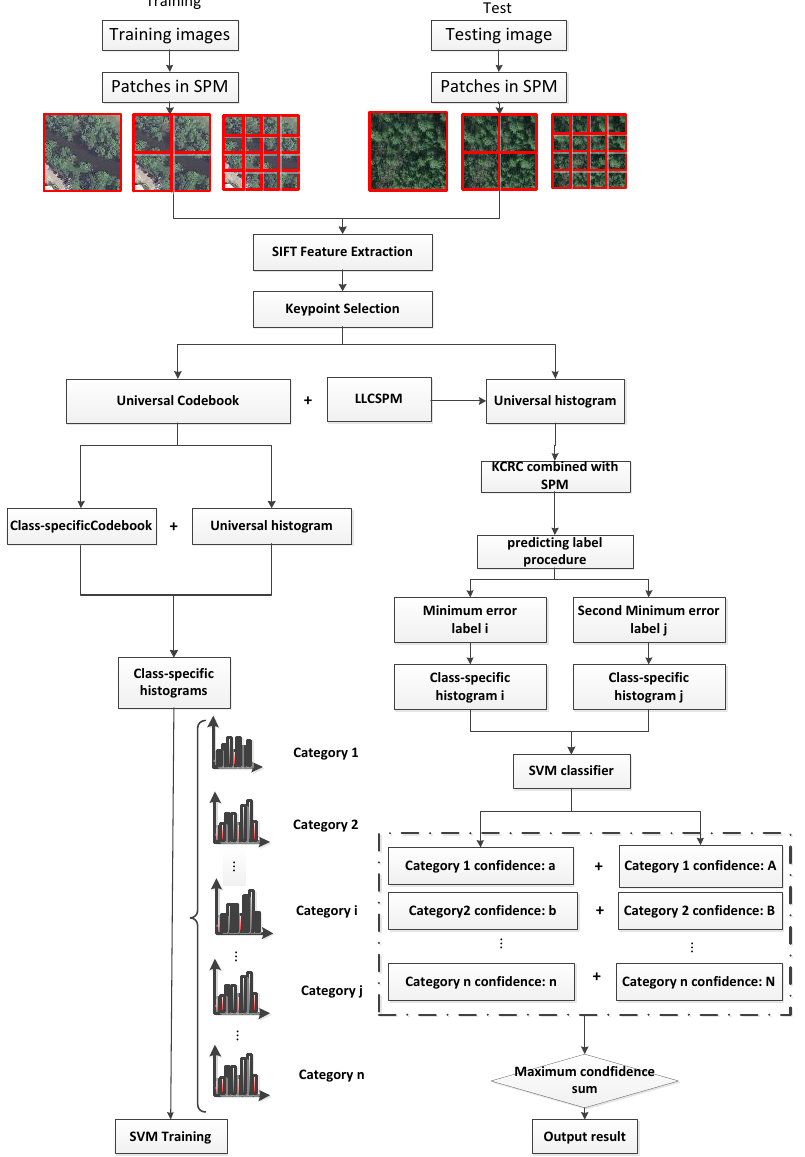
Figure 4. Overview of the improved class-specific BOW model for land-use scene classification.